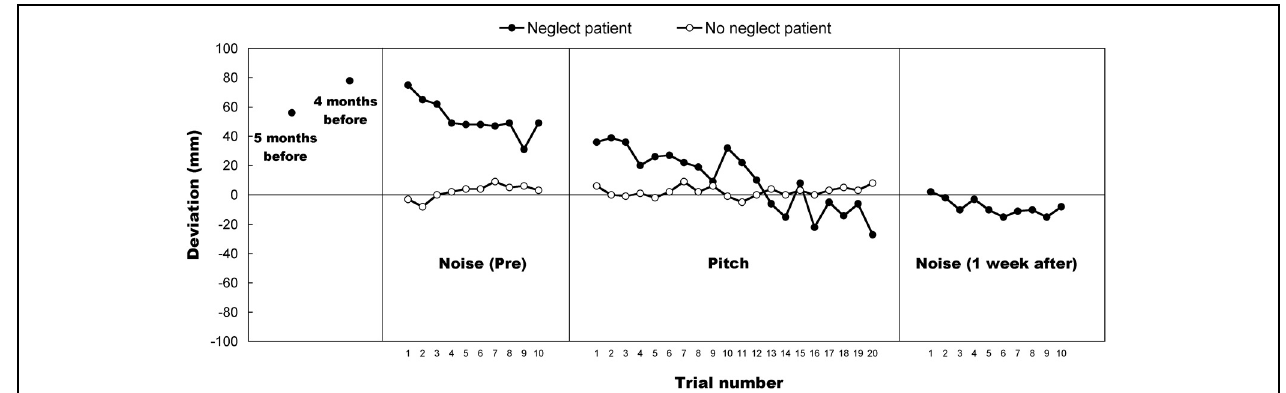
FIGURE 3 | A shift of the deviation as a function of the trial in each patient (filled circle: neglect; unfilled circle: no neglect). The patients started with 10 bisections performed with a white noise. During this period a transient trend was observed in both patients, followed by a plateau. The neglect patient then performed the task with the pitch alternation of “Low, High, Low, High, ··· ” for the first half 10 trials and “High, Low, High, Low, ··· ” for the later half 10 trials. The no-neglect patient performed the task with the reversed order of alternation: “High, Low, High, Low, ··· ” for the first half 10 trials and “Low, High, Low,